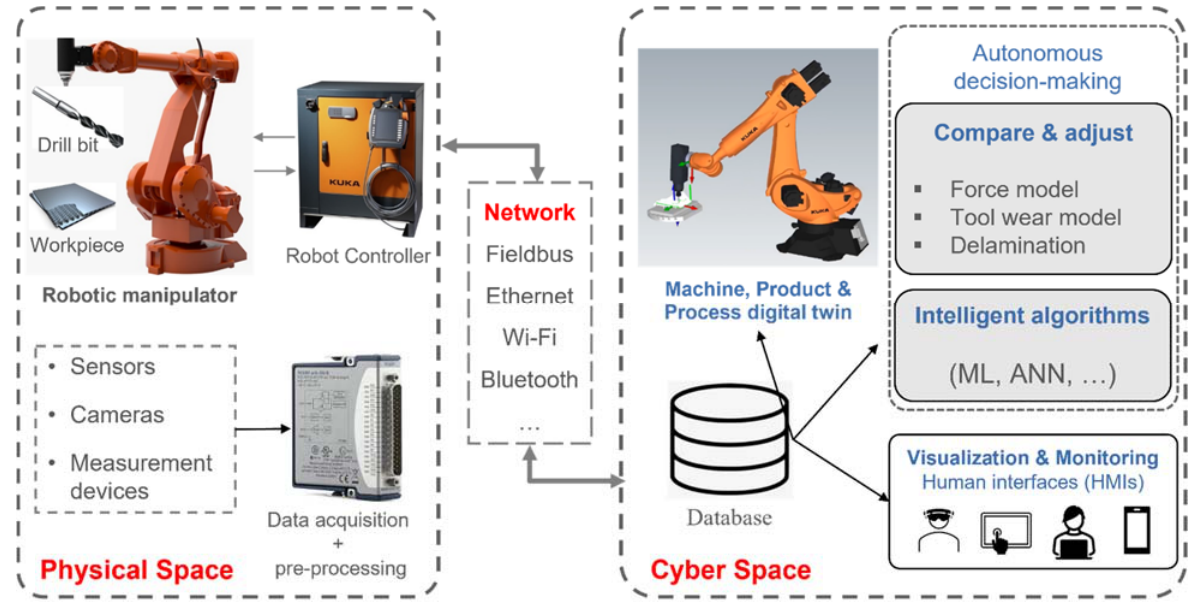
Figure 1. Generic framework of digital twin for robotic drilling process. ML = Machine Learning, ANN = Artificial Neural Network.